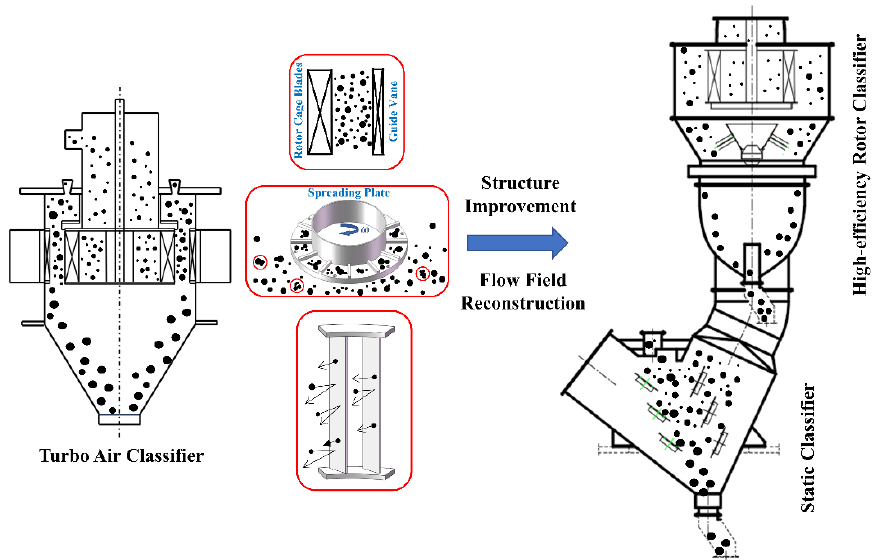
Figure 1. The turbo air classifier (left) and the new combined classifier (right).